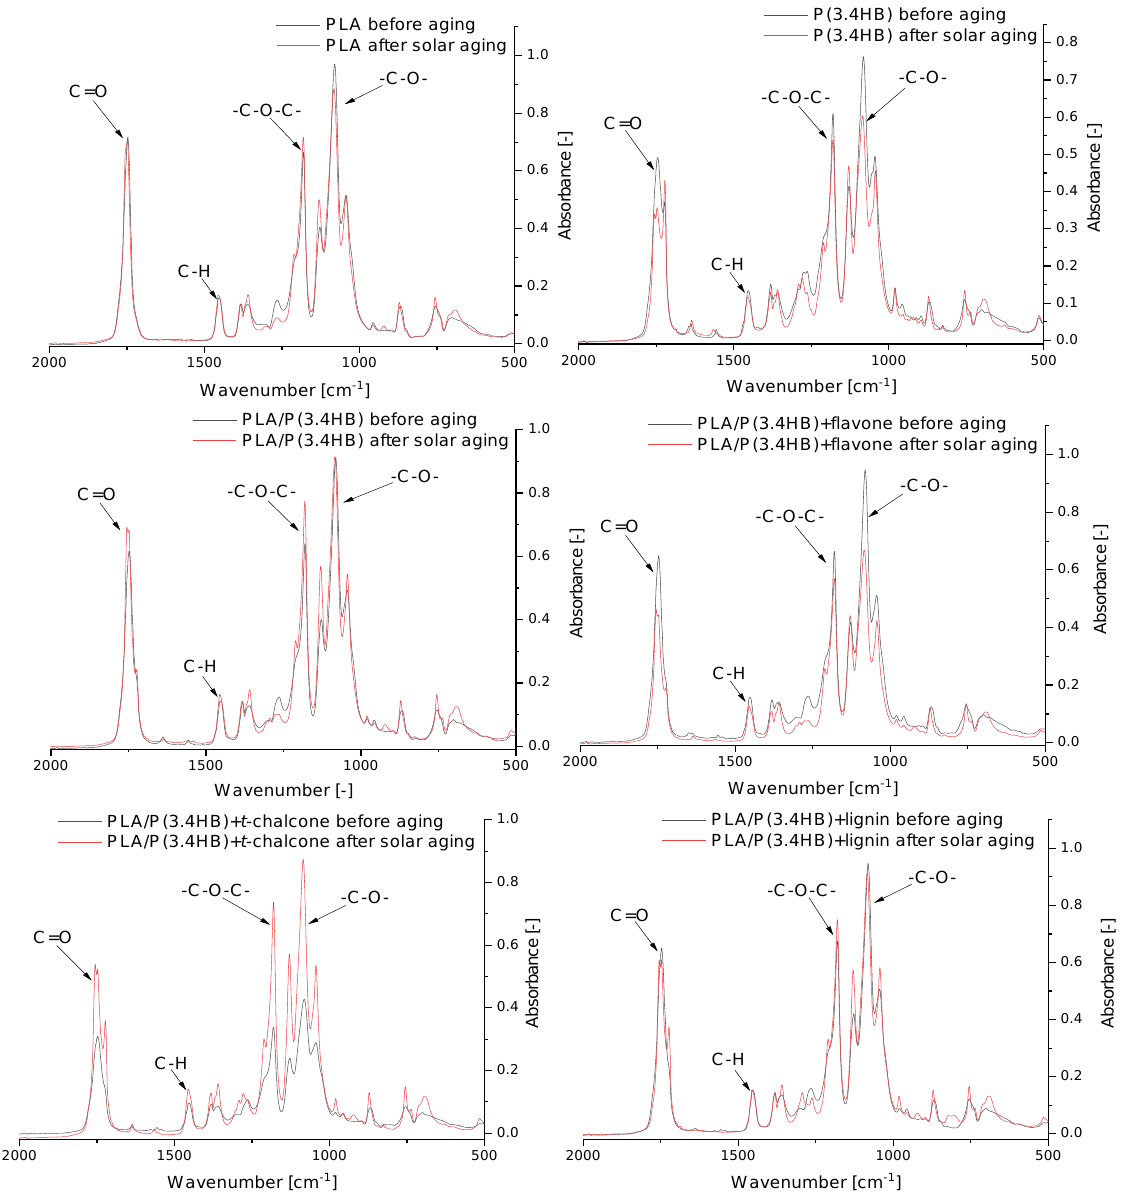
Figure 6. FT-IR spectra of PLA, P(3.4 HB), and blends with antioxidants before and after solar aging.